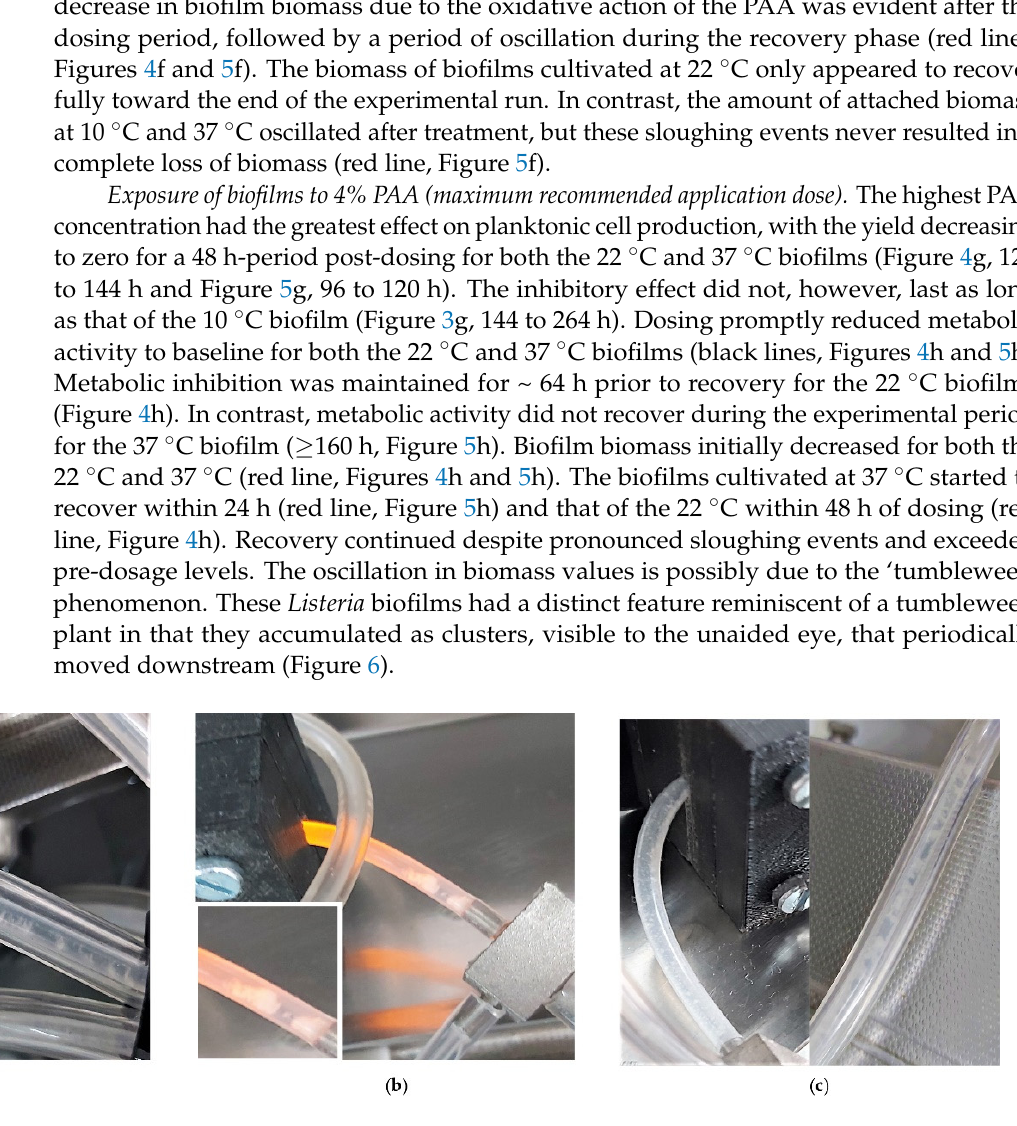
Figure 6 . Photographs of sessile growth of L. monocytogenes serovar ½a EGD-e at various temperatures in the silicone tubing of the combined CEMS-Biospec system. These Listeria biofilms had a distinct feature reminiscent of tumbleweeds in that they accumulate as clusters that are visible to the unaided eye. These clusters periodically moved downstream through the system. ( a ) The patchy and ball-shaped microcolonies are surrounded by a network of knitted chains near the inflow of the CEMS-Biospec system [24]. ( b ) Larger clusters of the ball-shaped/tumbleweed microcolonies in the tubing just upstream of the BioSpec. ( c ) Smaller clusters of biomass attached to the tubing downstream of the Biospec and CEMS